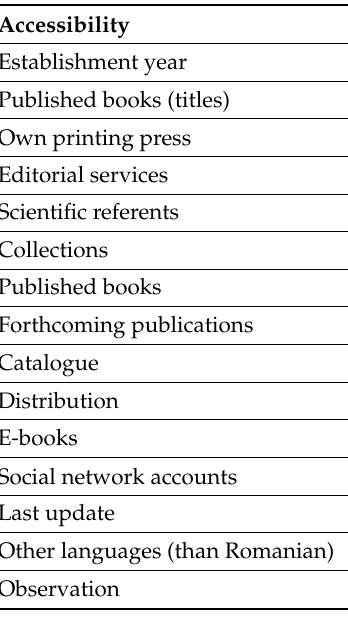
Table A1. Data collection form for university